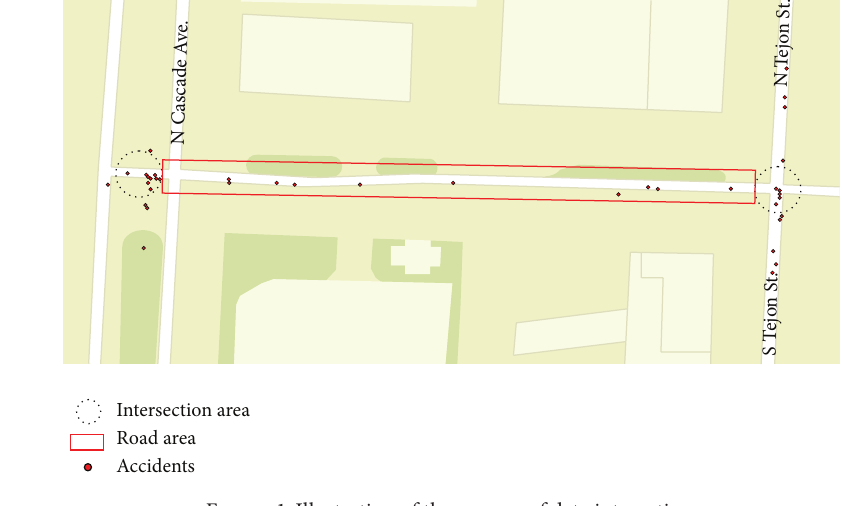
Figure 1: Illustration of the process of data integration.